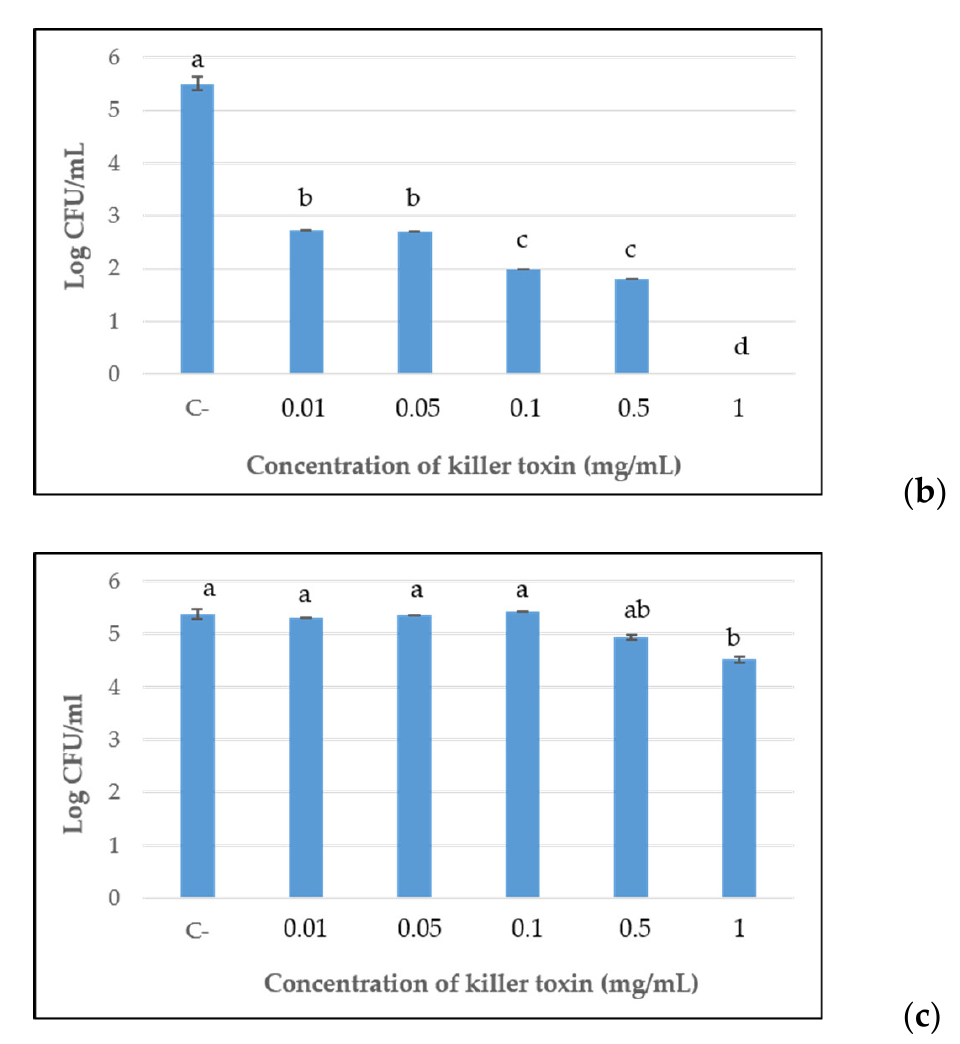
Figure 2. Viable cell counts of B. bruxellensis after 96 h of incubation with different concentration of killer toxins. ( a – c ) graphs represent the sensitive yeast incubated with D2, D15 and D18 toxins, respectively. C- represents the negative control where no killer toxin was added. Data mean ± standard deviations (error bars) and values showing different superscript letters ( a,b,c,d ) within each graph indicate significant differences between the treatments, according to Duncan test ( p < 0.05).